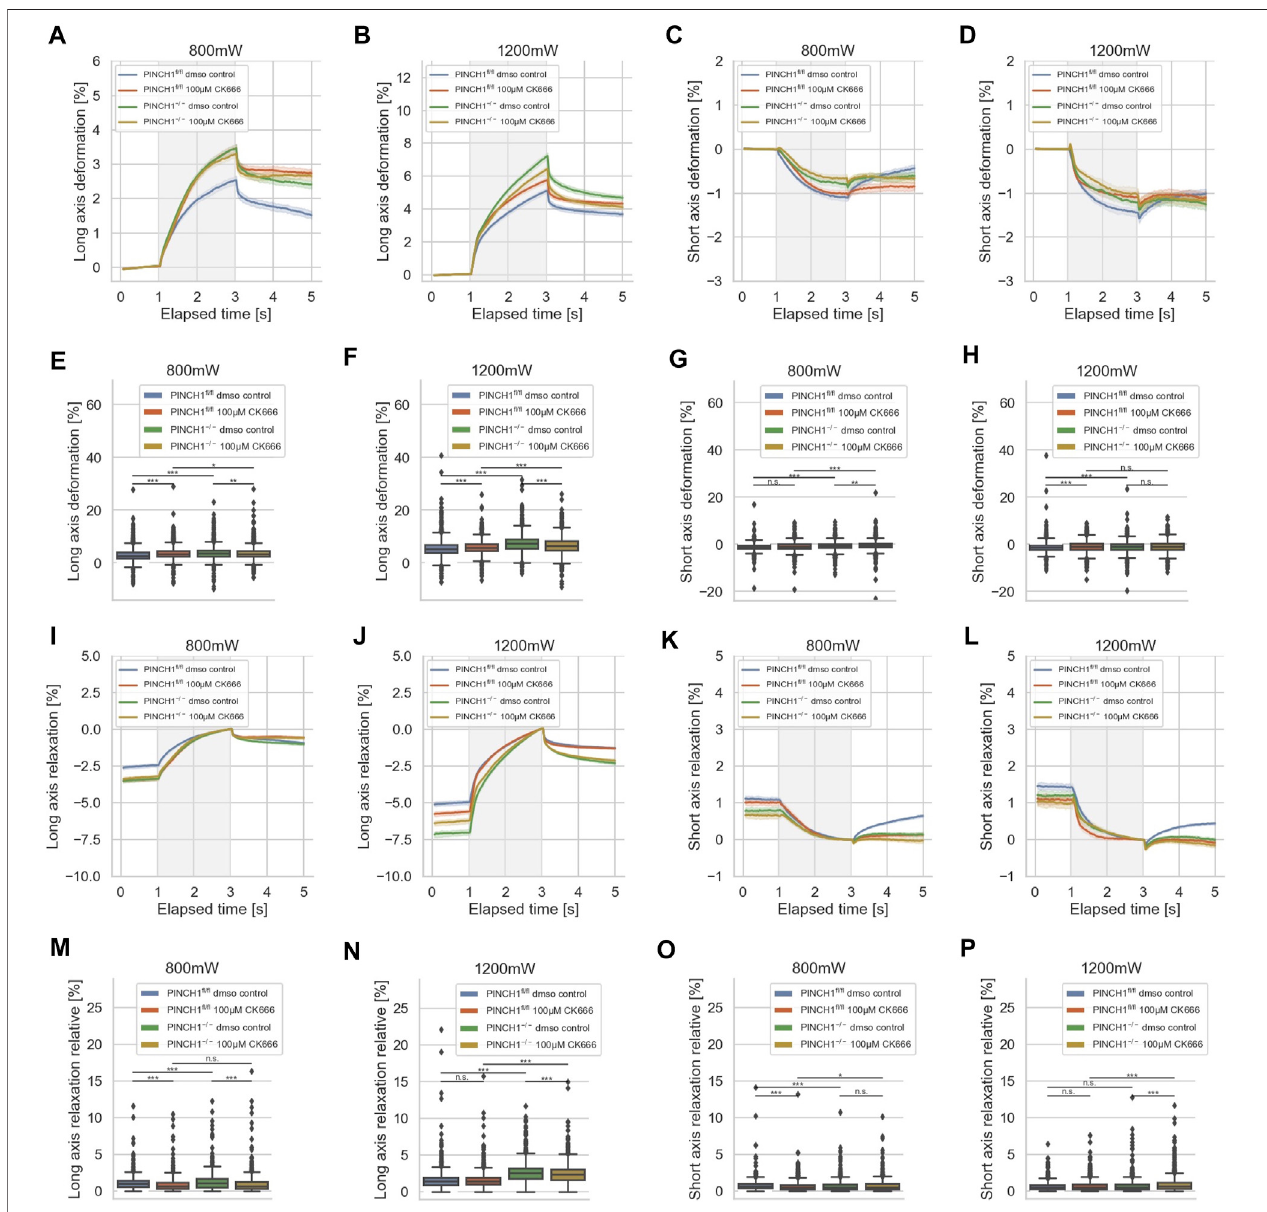
FIGURE 8 | Effect of CK666 on cellular deformability. Cellular deformability of PINCH1 − / − cells and PINCH1 fl / fl cells were measured at 800 mW laser power in the presence(medianvalues, n =1,683cellsforPINCH1 − / − cells(yellow)and n =1,630cellsforPINCH1 fl / fl cells(red))ofabsenceofCK666(medianvalues, n =1,596cellsfor PINCH1 − / − cells (green) and n = 1,641 cells for PINCH1 fl / fl cells (blue), respectively and 1,200 mW (median values, n = 1,778 cells for PINCH1 − / − cells (yellow) and n = 1,697 cells for PINCH1 fl / fl cells (red)) of absence of CK666 (median values, n = 1,583 cells for PINCH1 − / − cells (green) and n = 1,687 cells for PINCH1 fl / fl cells (blue) using an optical cell stretcher. The deformability curves of PINCH1 − / − cells and PINCH1 fl / fl cells at their long axis (A,B) , and short axis (C,D) with/without CK666 treatment. (E,F) Maximal deformability of PINCH1 − / − cells and PINCH1 fl / fl cells at laser powers of 800 – 1,200 mW at their long (E,F) and short (G,H) axis in the presence or absence of CK666 treatment. After the stretching process, the viscoelastic relaxation is observed for 2 s (I – P) . Relaxation behavior curves of the long axis for PINCH1 − / − cells and PINCH1 fl / fl cells at laser powers of 800 mW (I) and 1,200 mW (J) with/without CK666 treatment. (K,L) Short axis relaxation curves of PINCH1 − / − cells and PINCH1 fl / fl cells at the two laser powers with/without CK666 treatment. (M,N) Maximal relaxation (at time point 3 s, where the deformation is maximal) of PINCH1 − / − cellsandPINCH1 fl / fl cellsatthetwolaserpowersattheirlongaxiswith/withoutCK666treatment. (O,P) MaximalrelaxationofPINCH1 − / − andPINCH1 fl / fl cells at the two laser powers at their short axis with/without CK666 treatment. (A – D, I – L) Data are presented as median values with a 95.0% con fi dence interval (E – H, M – P) data are presented as box and whiskers plots (Q2 represent median values). (A – P) The experiments have been conducted as 4 to 6 independent repetitions. (*** p < 0.001, ** p < 0.01, * p < 0.05, n.s. = not signi fi cant; Kruskal-Wallis